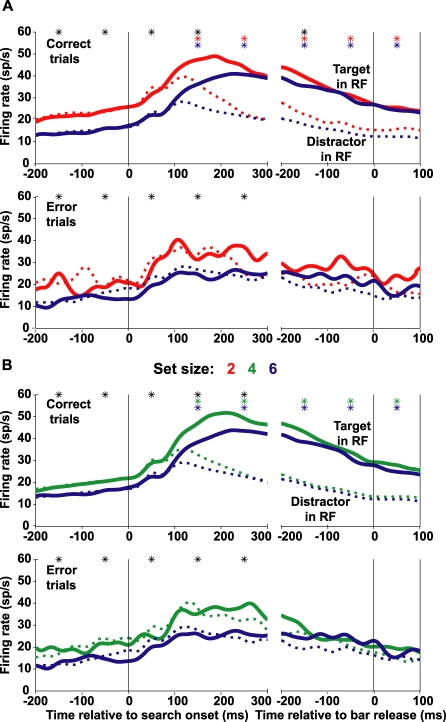
Firing Rates in Correct and Error Trials(A) Average firing rates in correct and error trials, when the target (solid) or a distractor (dashed) was in the RF at set sizes 2 and 6. Data are from 55 neurons that had at least three error trials in each category. The black asterisks (top row) show 100 ms time bins in which firing rates differed significantly between the two set sizes. The red and blue asterisks (next two rows) show 100 ms time bins in which firing rates differed significantly between target and distractors in the RF at the corresponding set size.(B) Same as in (A), for 53 neurons tested at set-size 4 and 6.